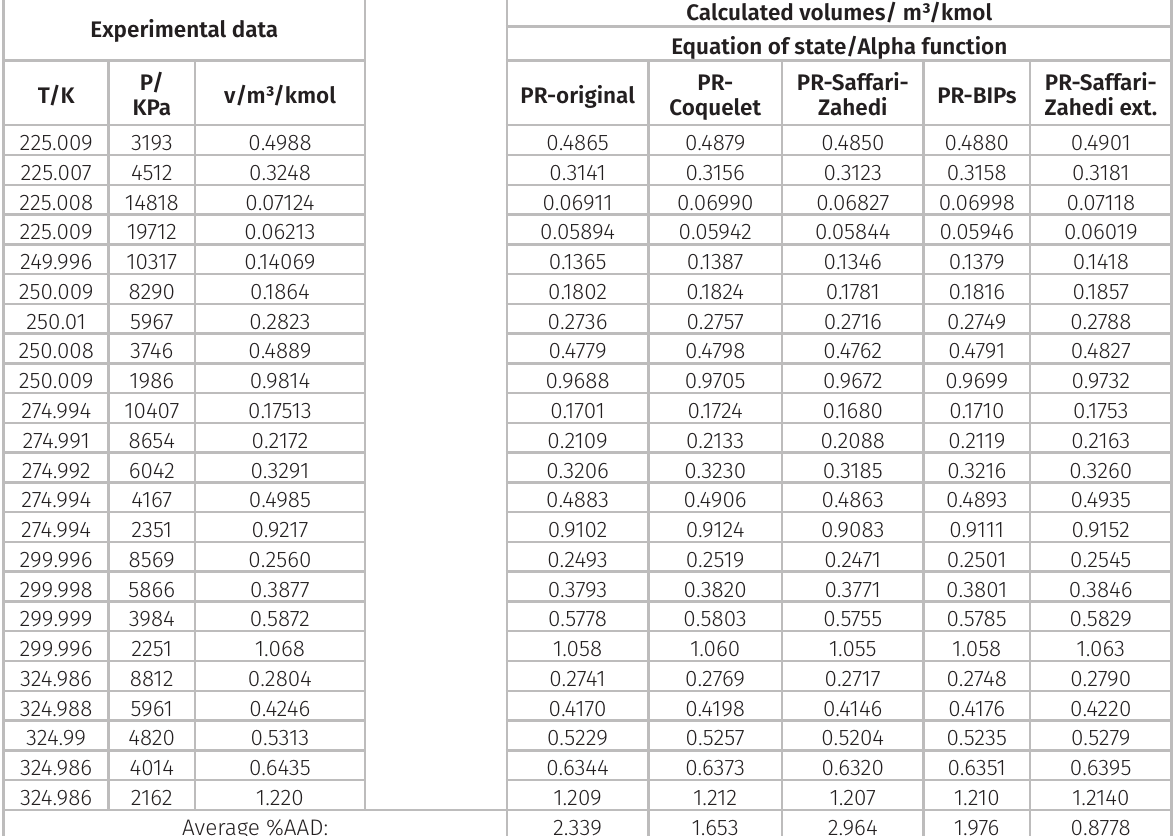
Table VI. Experimental and calculated molar volumes for mixture GN10. Experimental